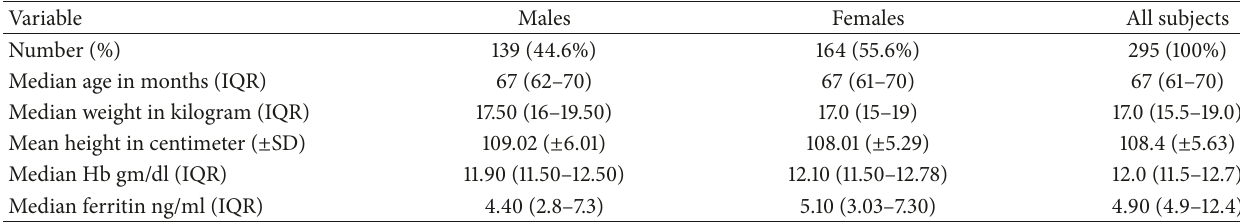
Table 1: Baseline characteristics of males, females, and all subjects.